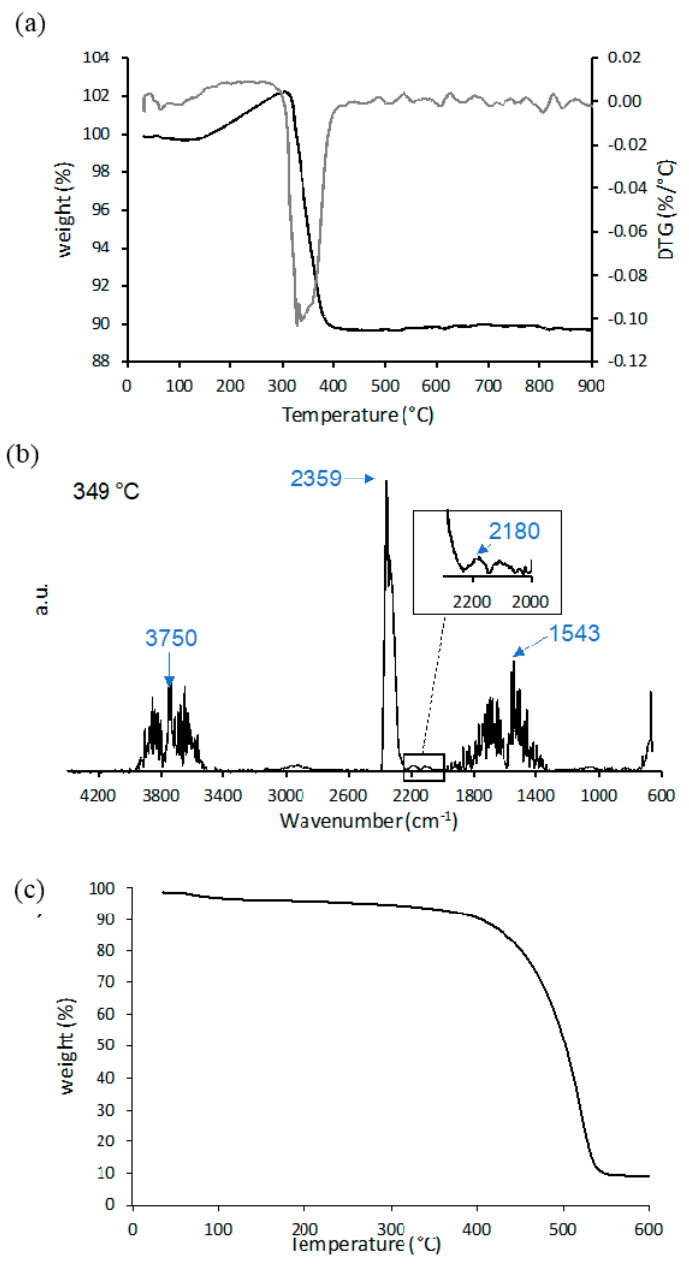
Figure 4. TGA-IR data of biochar–BiO x . ( a ) TGA and first derivative, ( b ) IR spectra of developed gases at 349 °C and ( c ) TGA of bare biochar Table 1. Weigh loss percentages for biochar and biochar–BiO x samples.